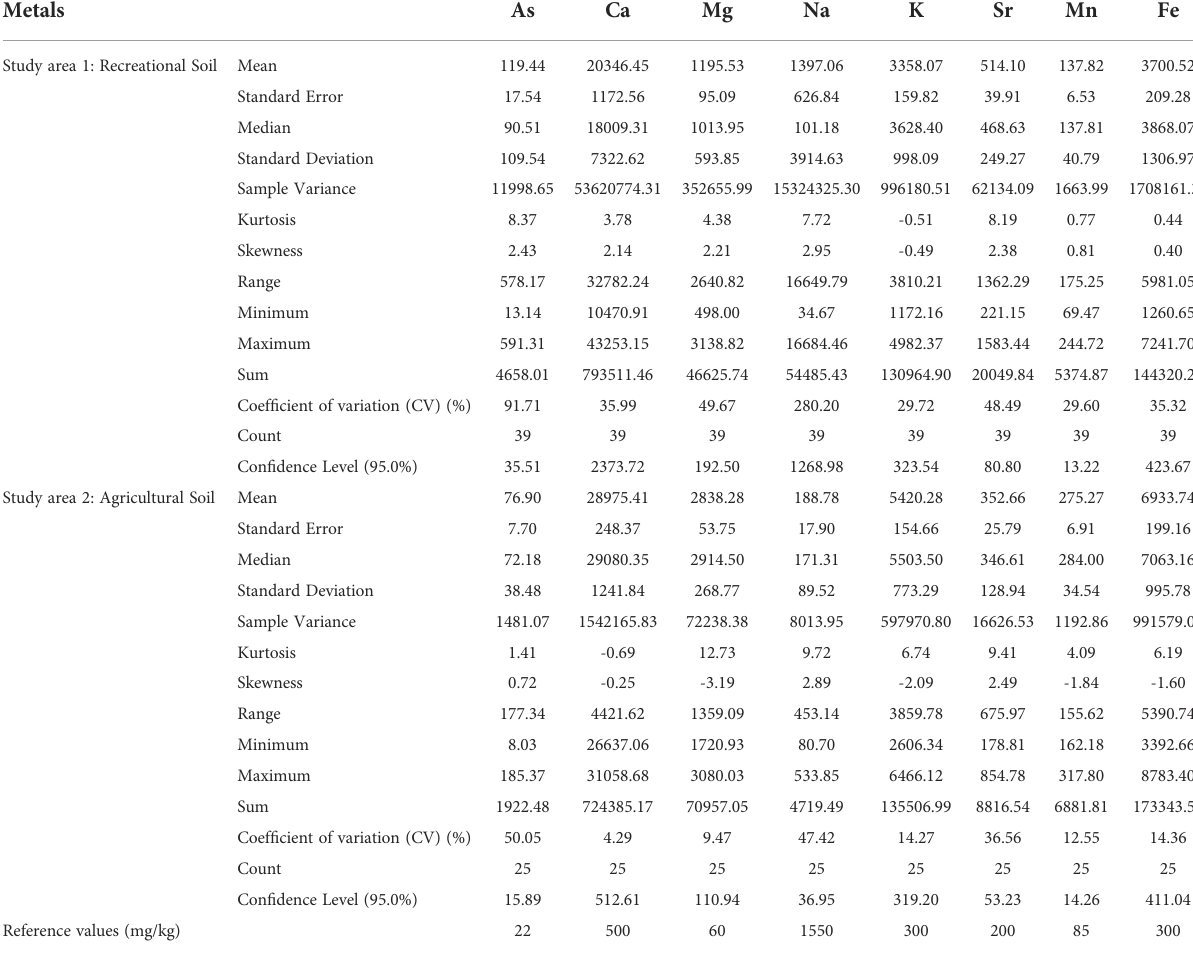
TABLE 2 Descriptive statistics of metal concentrations for soil physicochemical